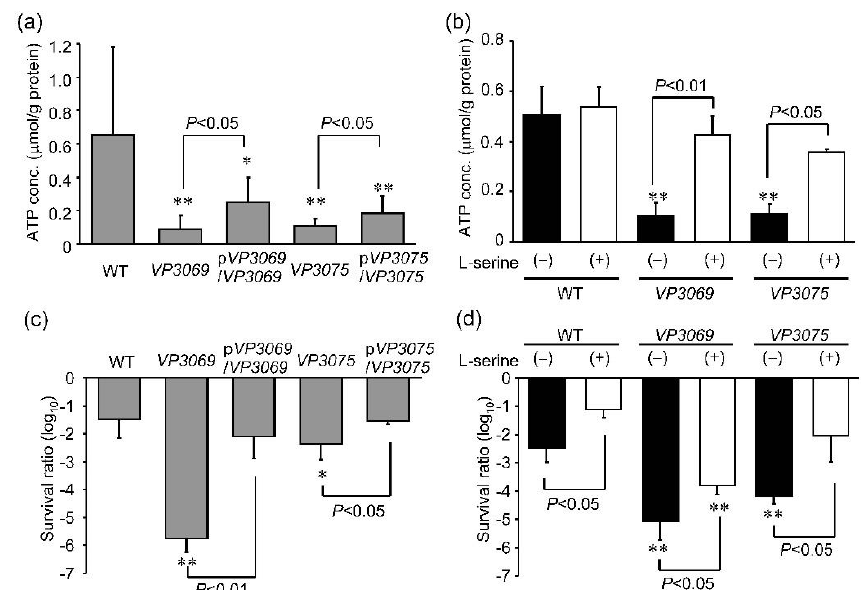
Figure 4. Intracellular ATP concentration and sensitivity to UVA irradiation in the mutants of F 0 F 1 -type ATP synthase genes. ( a , b ) ATP concentrations in response to gene complementation of F 0 F 1 -type ATP synthase gene mutations, p VP3069 / VP3069 and p VP3075 / VP3075 . ( c , d ) WT and mutant strains in the absence ( ■ ) or presence of 20 mM L-serine (□). Intracellular ATP concentration was measured by a luciferase/luciferin reaction as described in the materials and methods section. ( c , d ) Sensitivity to UVA irradiation was measured as described in the materials and methods section. Values shown are means ± SD (n = 3–7, n = number of independent experimental replicates). * p < 0.05 or ** p < 0.01 versus WT.